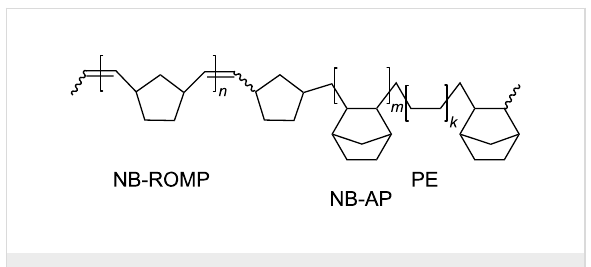
Figure 3: The multiblock copolymer capable of post-functionalization [76].